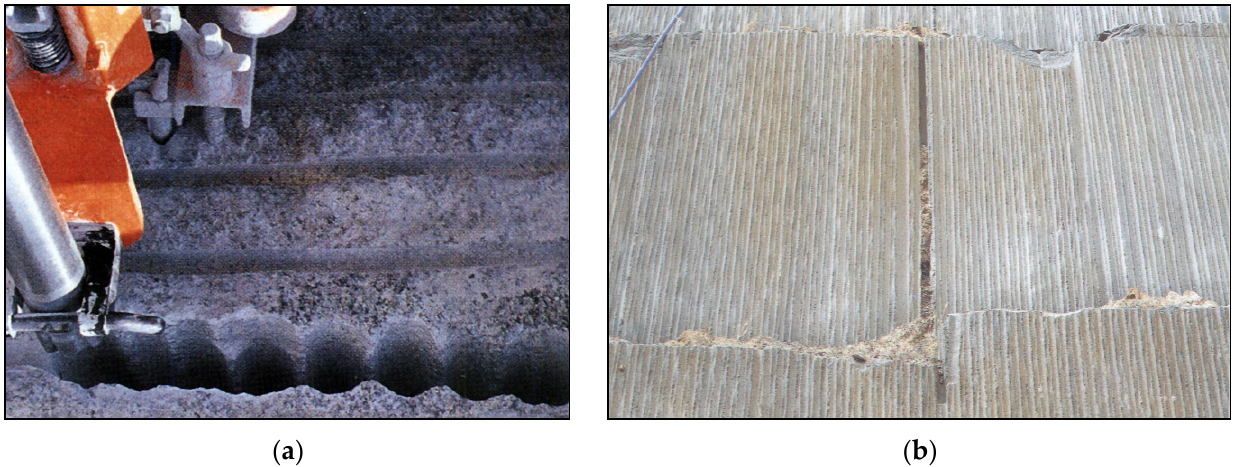
Figure 4. Example of a blasting pattern with indication of the main parameters involved. In partic- ular, the representation of the terms E c and V c (referring to Tables 1 and 2) should be noted [5].